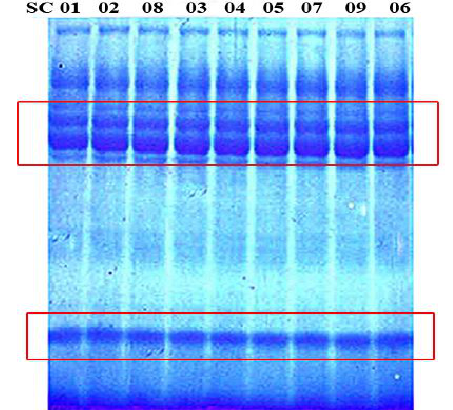
Fig. 2 . SDS-PAGE of whole-cell bacterial protein showing an identical pattern in whole samples